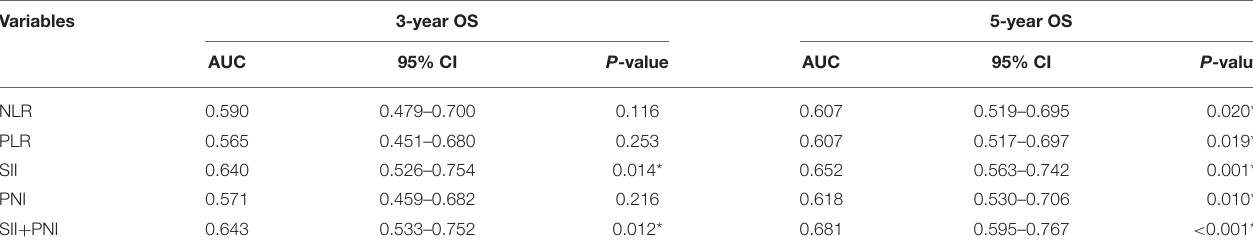
TABLE 3 | Predictive ability of NLR, PLR, SII, PNI, SII + PNI for 3-year and 5-year OS in skull base